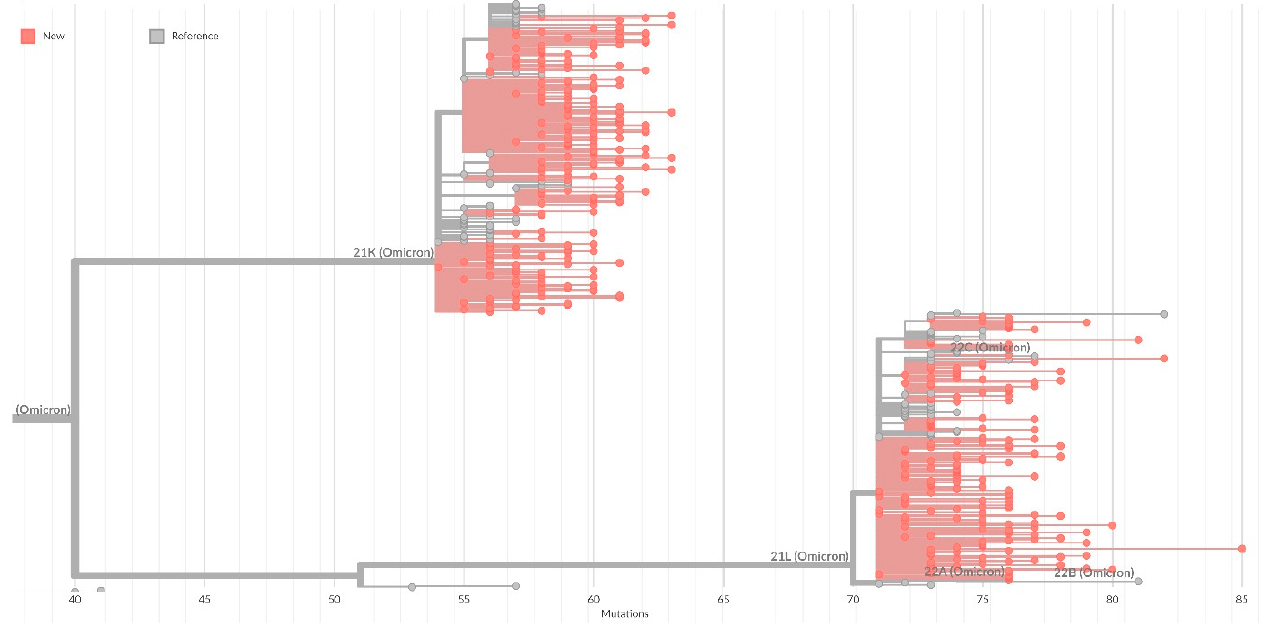
Figure 4. SARS-CoV-2 phylogenetic tree reconstruction of Omicron branches based on Nextclade tools. Strains obtained within this work are in red; strains from Nextstrain database are gray. The scale is in substitutions per site compared to the Wuhan-Hu-1/2019 reference sequence (GenBank: MN908947). 21K in Nextstrain lineage corresponds to BA.1 Pangolin lineage, 22 L lineage corresponds BA.2, 22A lineage corresponds BA.4, 22 B lineage corresponds BA.5, 22C lineage corresponds BA.2.12.1.